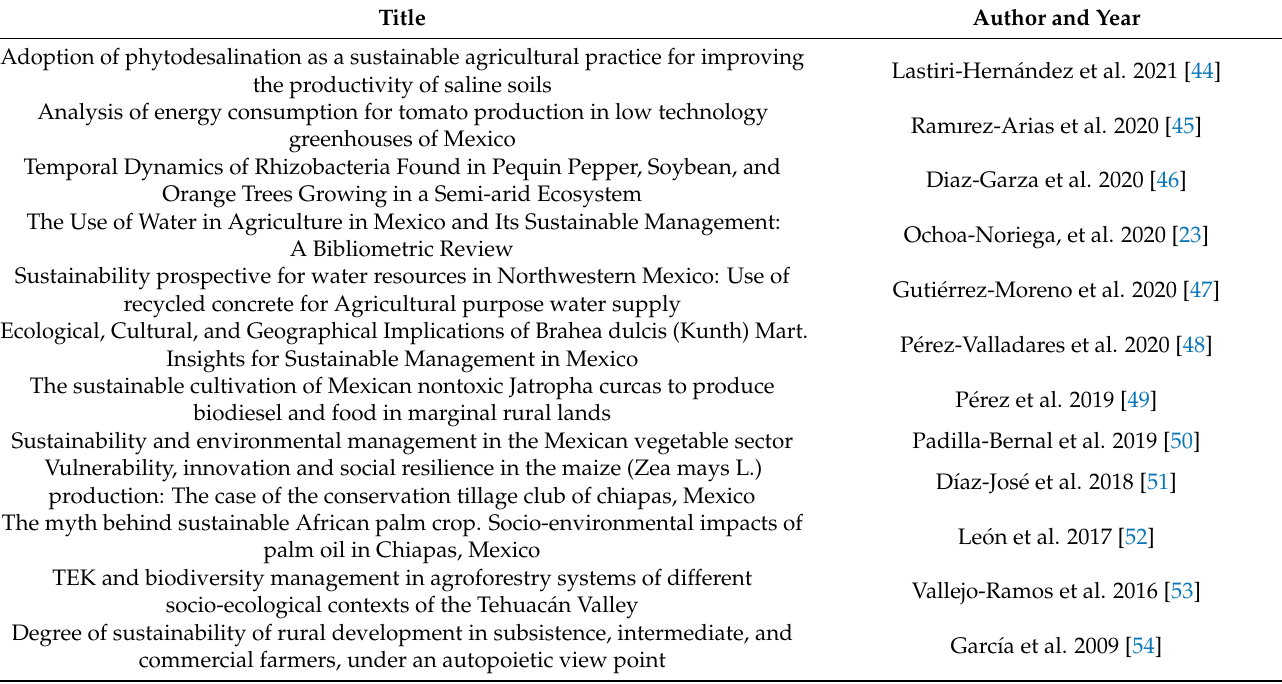
Table 1. Previous literature on sustainable agricultural management in